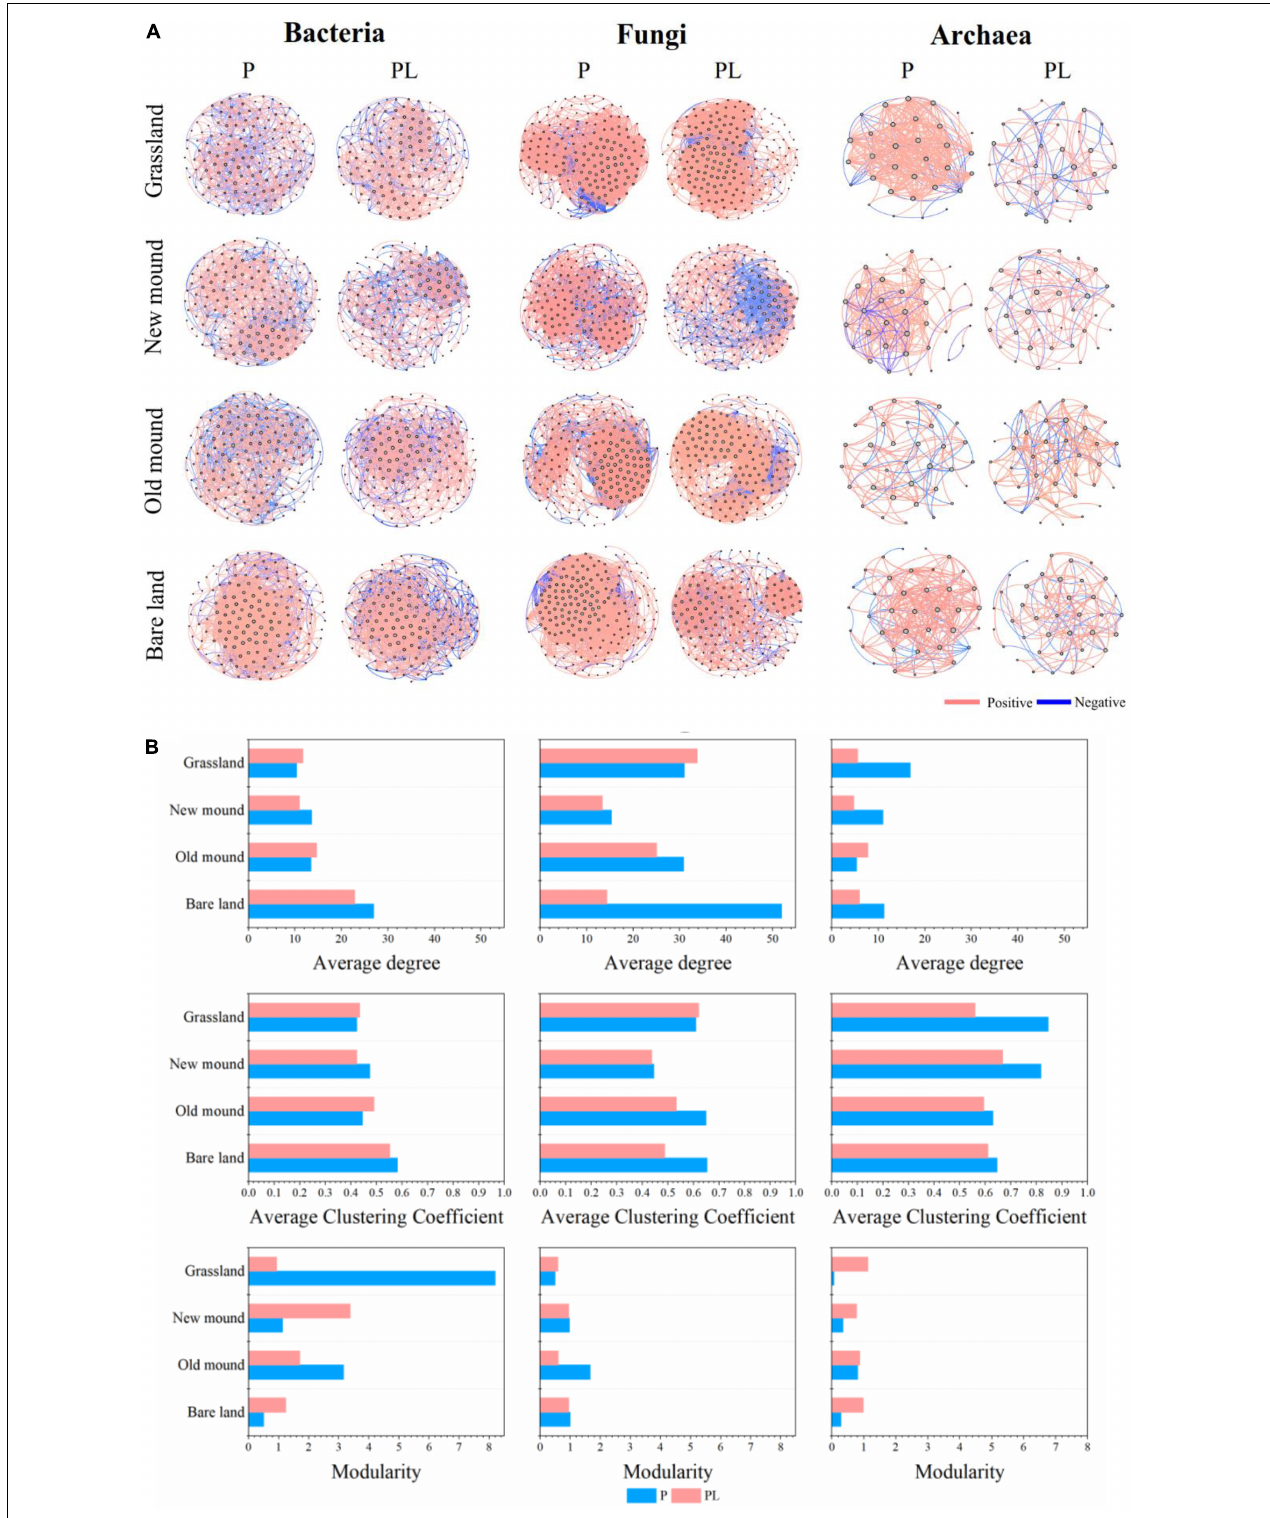
FIGURE 6 | The bacterial, fungal, and archaeal networks (A) and properties (B) in the grassland, new mound, old mound, and bare land. Nodes represent main OTUs (relative abundance > 0.01%); edges represent significant Spearman correlations (| r | > 0.7, P < 0.05). P (blue), pika disturbance; PL (pink), grazing and pika disturbance. (For detailed network properties, see Supplementary Table 8